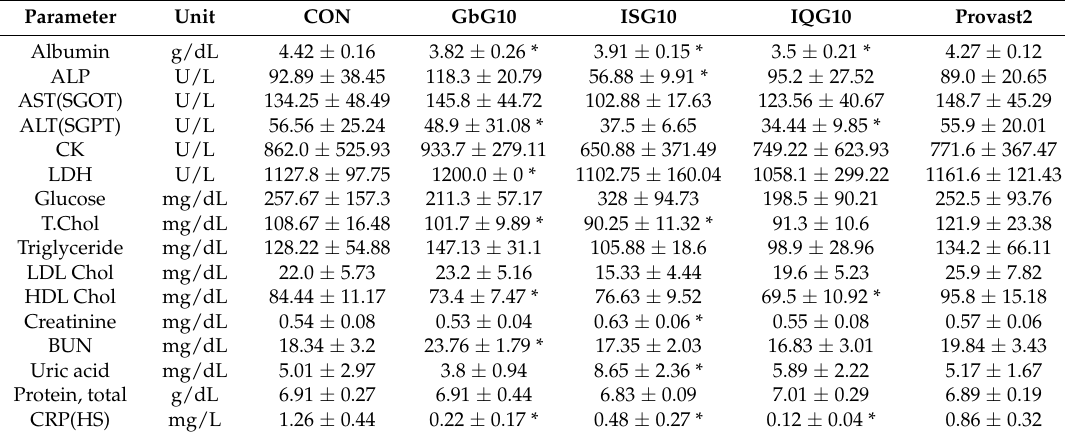
Table 2. Serological finding of insect glycosaminoglycan of high fat diet rats treated with insect glycosaminoglycan over a one month